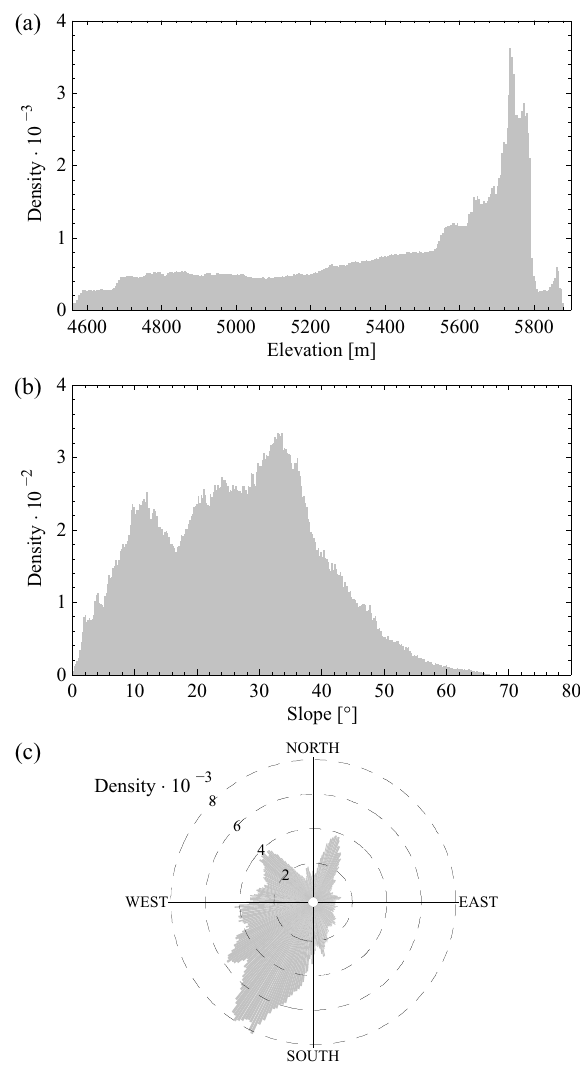
Fig. 3. Distribution of topographic measures from the areal extent of all ice bodies in 1912: (a) elevation, (b) slope, and (c) aspect. The magnitude of the normalised distribution on the y-axis is a proba- bility density function, with the integral equal to